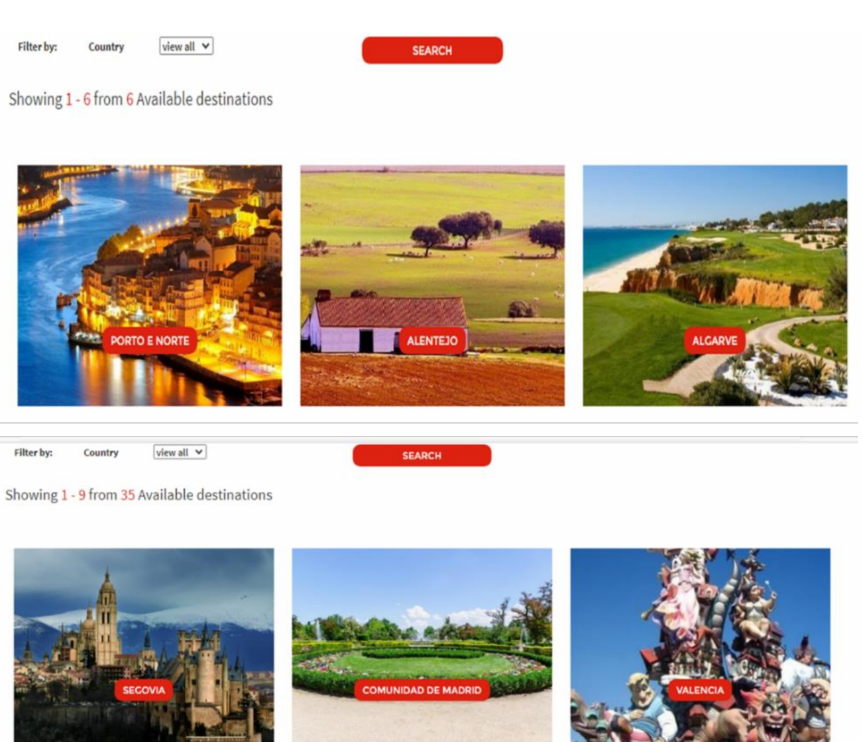
Figure 1. Mobile app of the platform to find the most accessible services and establishments of the tourist destination selected by the user. Source: Tur4all [52,53].